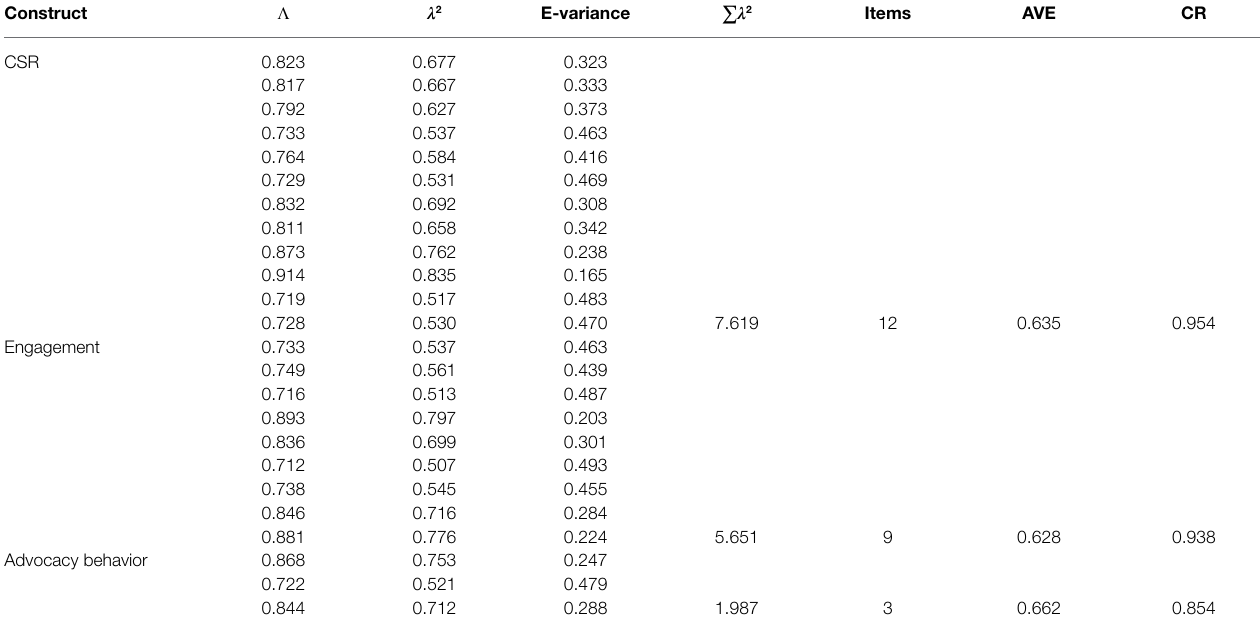
TABLE 4 | Outputs of construct evaluation. Construct